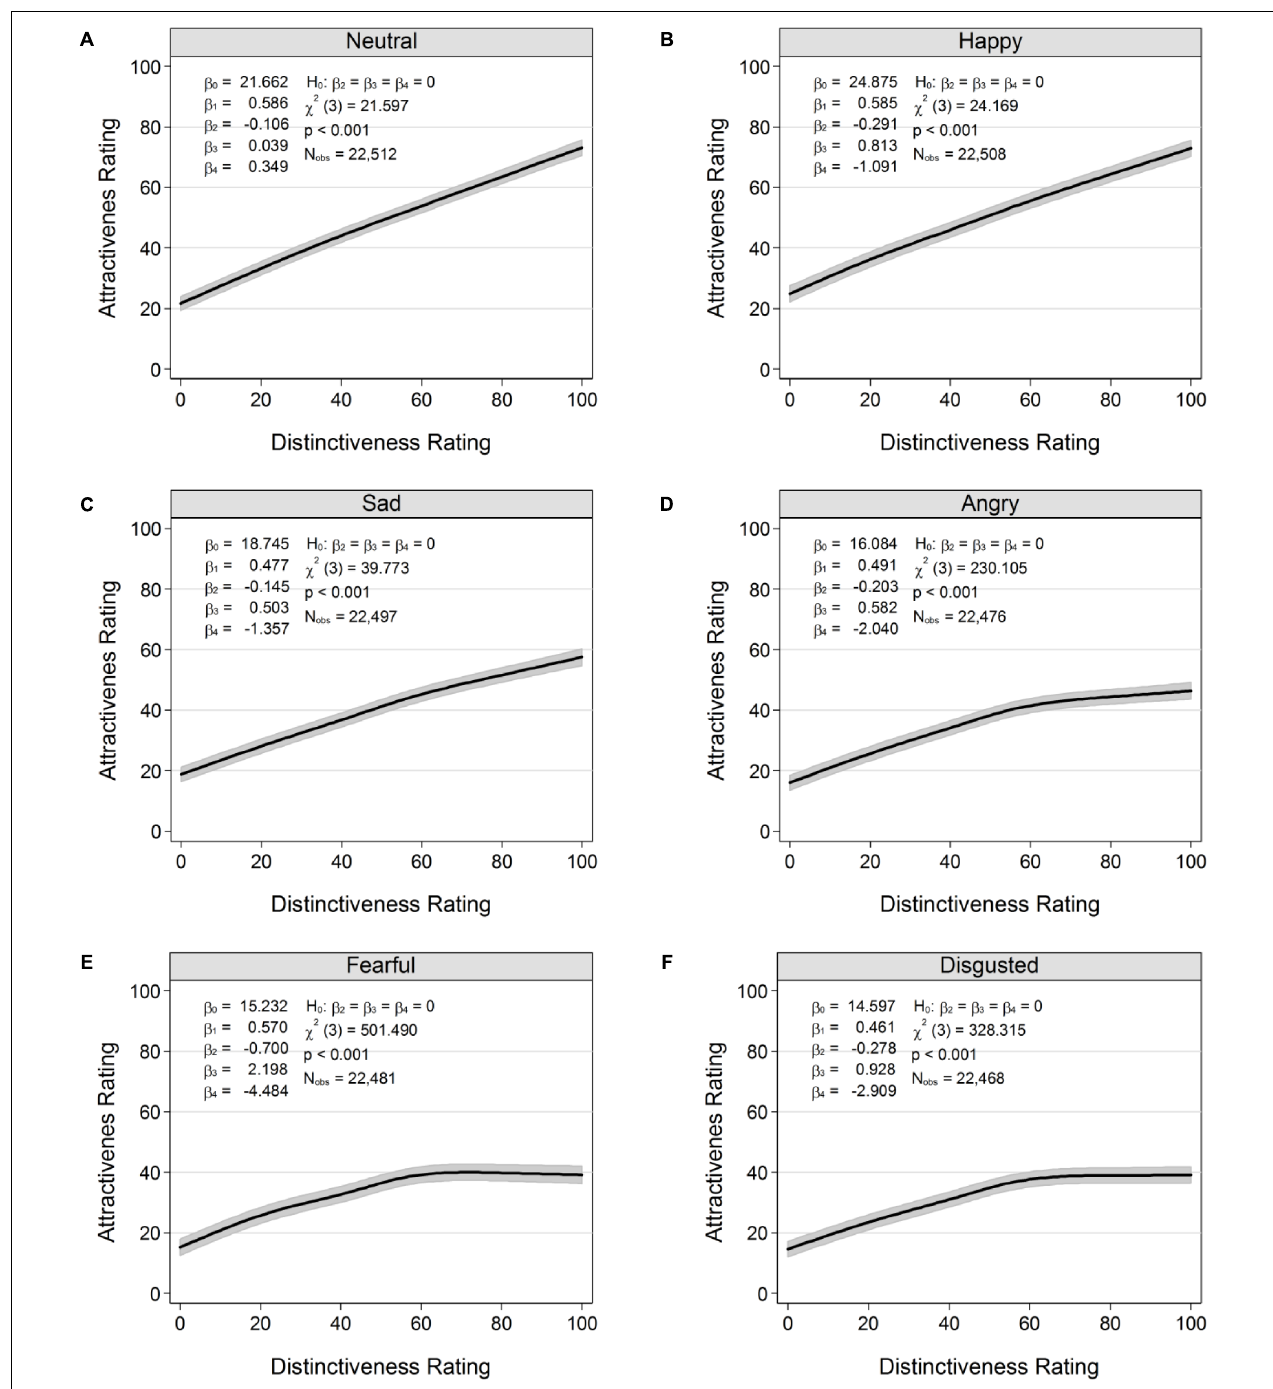
FIGURE 5 | Variations in the relation between attractiveness and distinctiveness ratings by emotion of face: (A) Neutral. (B) Happy. (C) Sad. (D) Angry. (E) Fearful. (F) Disgusted. Black lines show expected values of attractiveness, conditional on distinctiveness. Shaded areas indicate 95% confidence regions. Results were obtained from separate fits of multilevel restricted cubic spline models (Eq. 1). P = Perceiver; F =